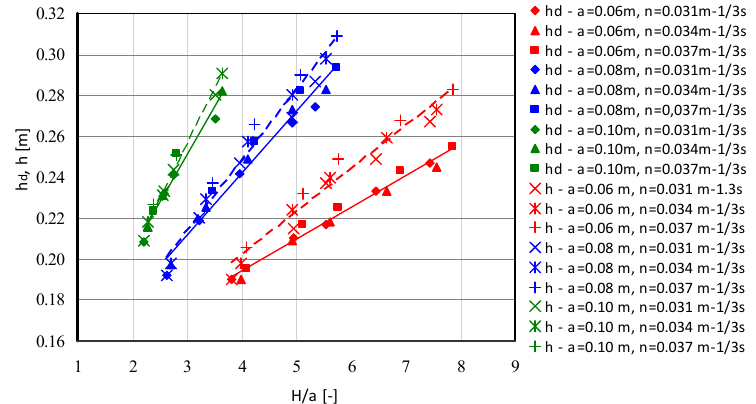
Figure 8. Comparison of the water depths h measured in the cross-section 3.035 m downstream of the gate and the depth h d ensuring agreement between the measured and calculated discharge, according to Equation (6).